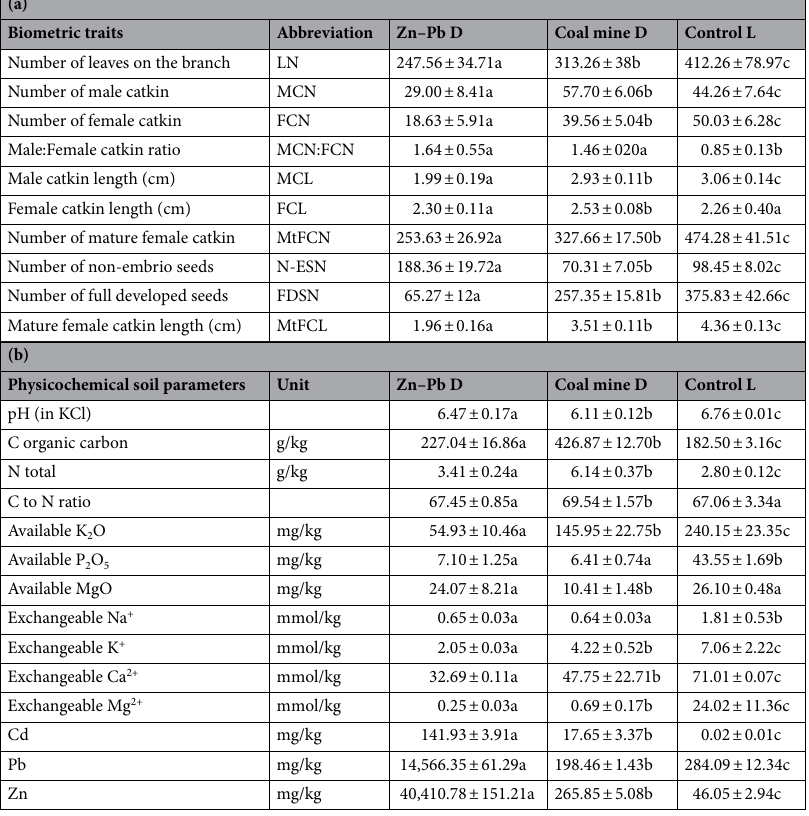
Table 2. Descriptive statistics (mean and standard deviation) and the results of Tukey’s HSD test: (a) the biometric traits of B. pendula populations; (b) the soil properties from the Zn–Pb D, Coal mine D, Control L sites (significance level α = 0.05; a different lower-case letter means significant